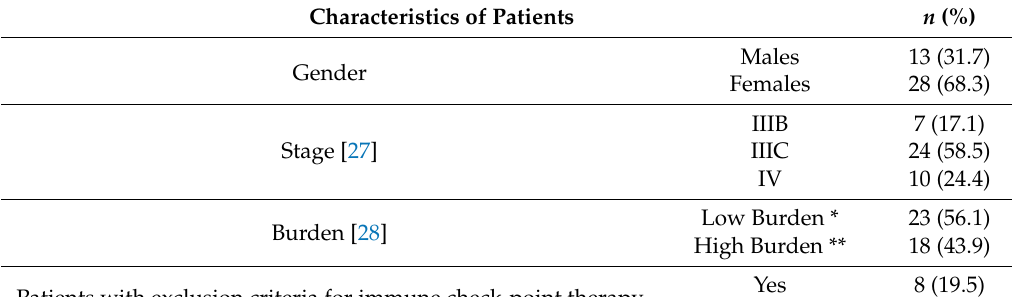
Table 3. Characteristics of patients and